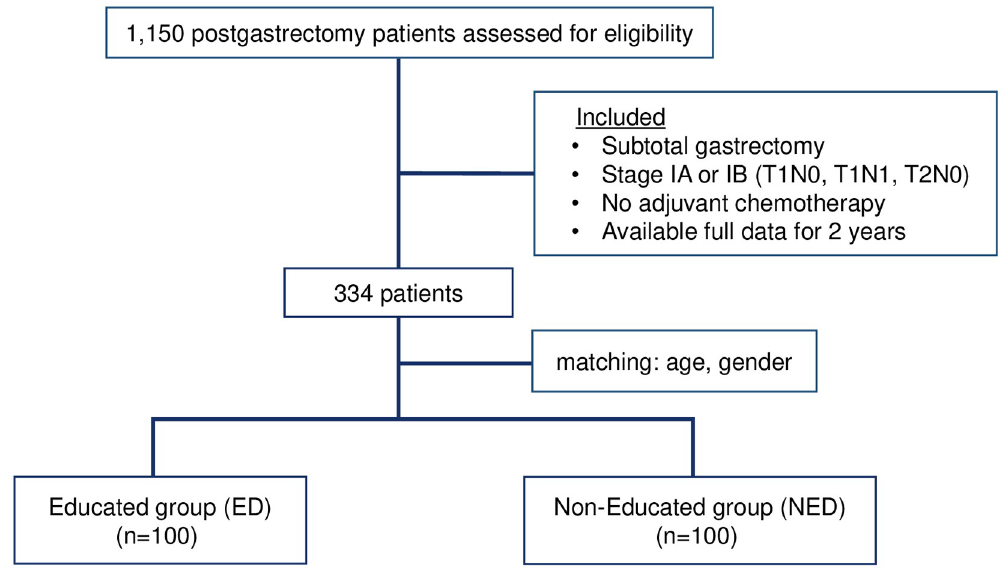
Fig 1. Scheme of the